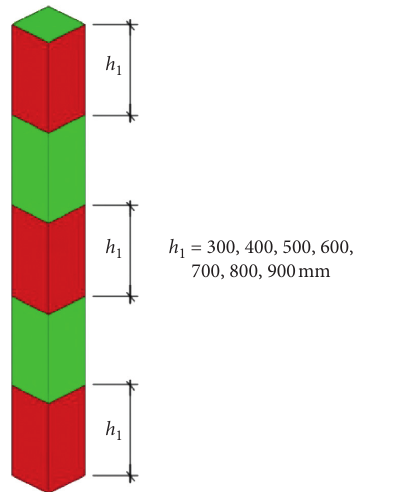
Figure 16: Design of retrofitting length.